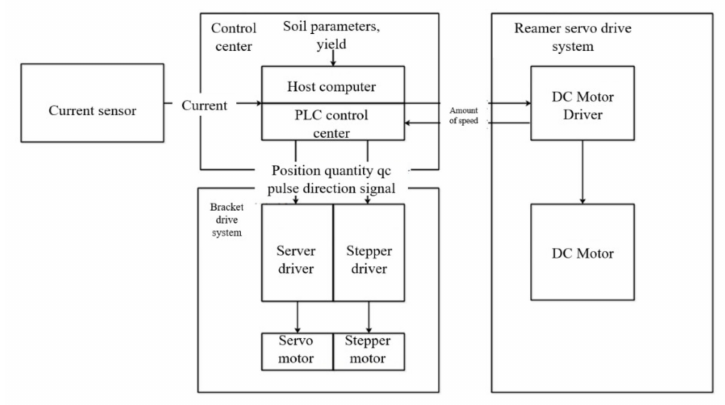
Figure 8. The structure diagram of the autonomic adaptive control